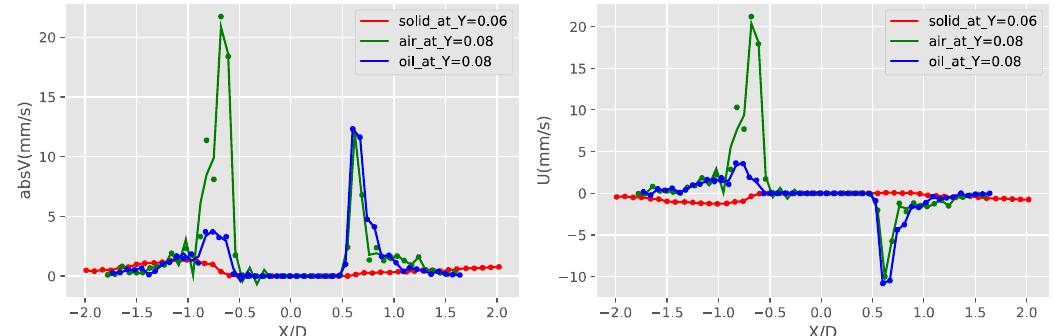
Figure 16. Comparison of the absolute velocities (absV) and X-component velocity (U) of the three types of obstruction Y/D = 0.08 (location of the gaseous bubble bubble velocity peak).